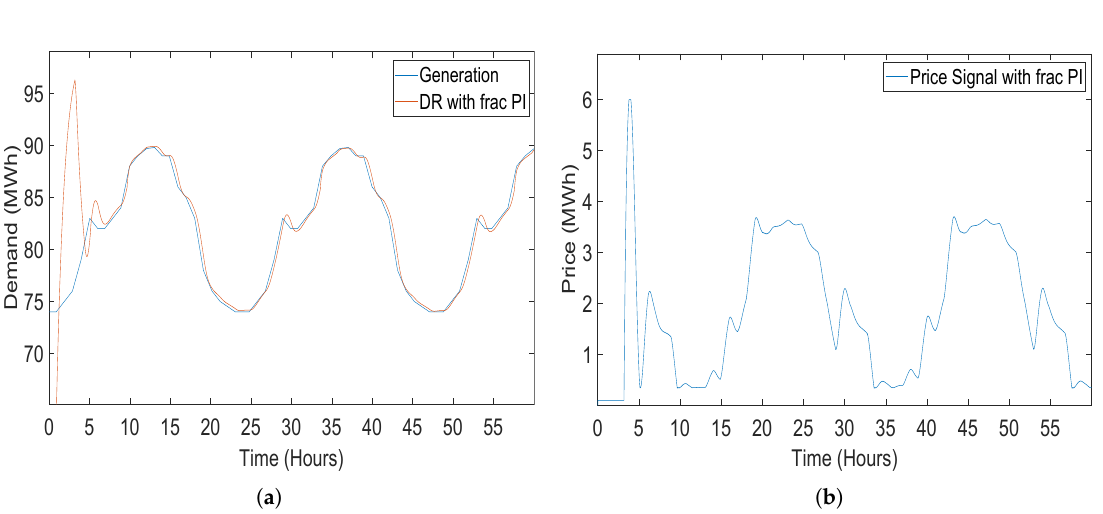
Figure 15. Closed-loop elastic demand control using a fractional order proportional integral (FOPI) controller having coefficient values K p = − 1, K p = − 2 and λ = 0.8: ( a ) demand response; ( b ) price